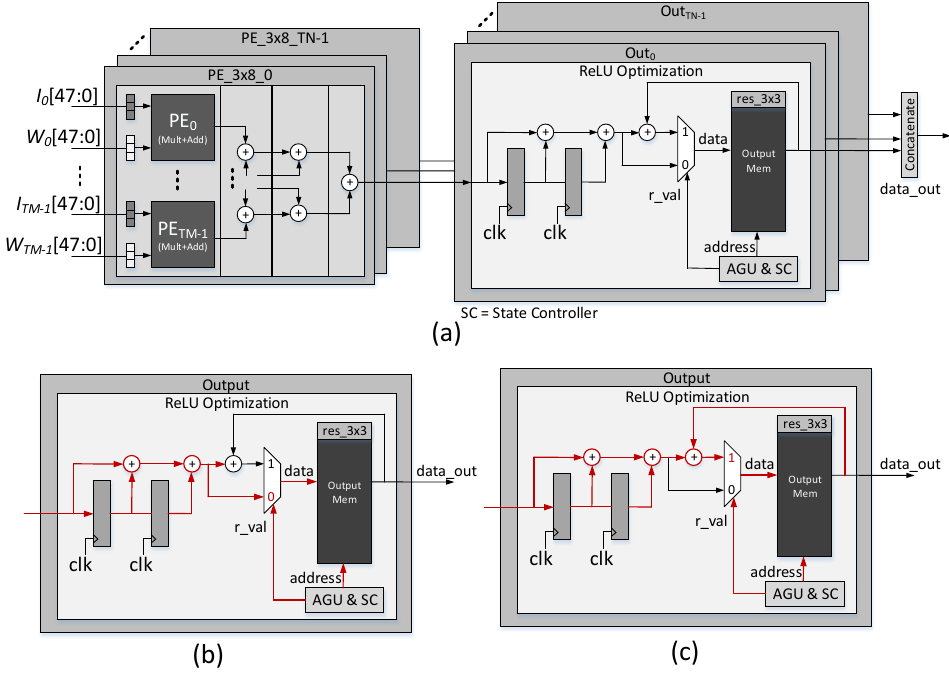
Figure 9. Proposed ReLU processing design. The AGU generates the required read/write address and SC produces the required control signals. ( a ) Interconnection between PEs and ReLU design in the output module. ( b ) Initially, a normal partial sum writes to output memories. ( c ) For the next partial sum, logic is implemented for reading, the addition of results, and writing back data to